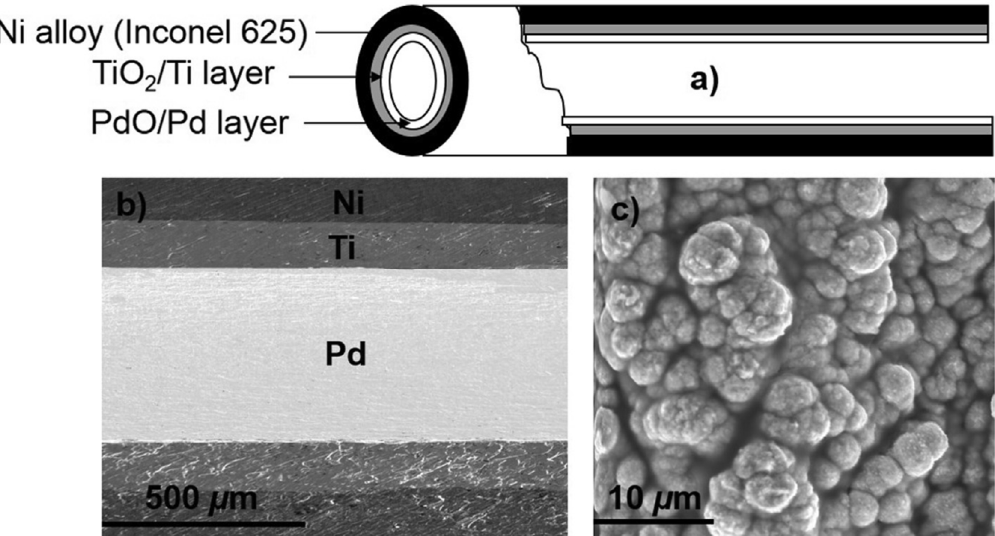
Figure 3. Images of the catalytic tubular reactor: ( a ) Schematic presentation of the tubular reactor; ( b ) Energy-dispersive X-ray spectroscopy (EDX) mapping of the longitudinal section of the Ni alloy (Inconel 625) tube with the TiO 2 / Ti secondary layer coated with the thin Pd layer; ( c ) Scanning electron microscopy (SEM) image of deposited Pd [180].